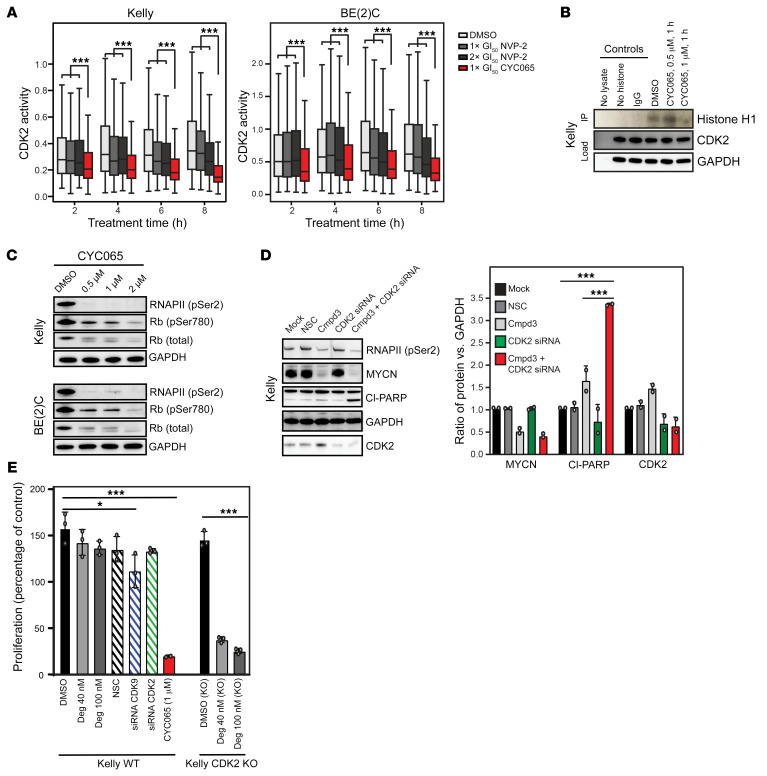
CDK9 and CDK2 synergistically maintain MYCN-amplified NB cells.(A) CDK2 activity is obtained by measuring the cytoplasmic-to-nuclear ratio of DHB-mVenus. Cell nuclei were identified using DAPI staining. Bold lines represent median, boxes represent the interquartile range (IQR), whiskers represent 1.5 times the interquartile range, and outliers are not shown. Welch’s 2-tailed t test with Benjamini and Hochberg correction for multiple comparison. ***P < 1 × 10–8. (B) Kelly cells were treated with CYC065 or DMSO and harvested after 1 hour. CDK2 complexes were immunoprecipitated from cell lysates followed by an in vitro kinase assay using histone H1 as a substrate (n = 2). (C) Kelly and BE(2)C cells were treated with CYC065 for the indicated concentrations (0.5–2 μM) for 8 hours. Immunoblots show expression of the Rb protein (n = 2). (D) Immunoblots and bar plots showing expression of MYCN and cleaved PARP when cells were treated with compound 3 (Cmpd 3) at 1 × GI50 and/or siRNA directed to CDK2. Data are represented as mean ± SD of 2 independent experiments. Two-tailed, unpaired Student’s t test with Benjamini and Hochberg correction for multiple comparisons. ***P < 0.001. (E) Proliferation of NB cells quantified using a CellTiter-Glo assay. Kelly cells with CRISPR Cas9–mediated knockout of CDK2 (KO) or endogenous (WT) CDK2 were treated with CYC065 (8 hours), Deg (THAL-SNS-032, 8 hours), and siRNA against CDK9 or CDK2 for 48 hours. Data are represented as mean ± SD of 3 independent experiments. Two-tailed, unpaired Student’s t test with Benjamini and Hochberg correction for multiple comparisons. *P < 0.05; ***P < 0.001.